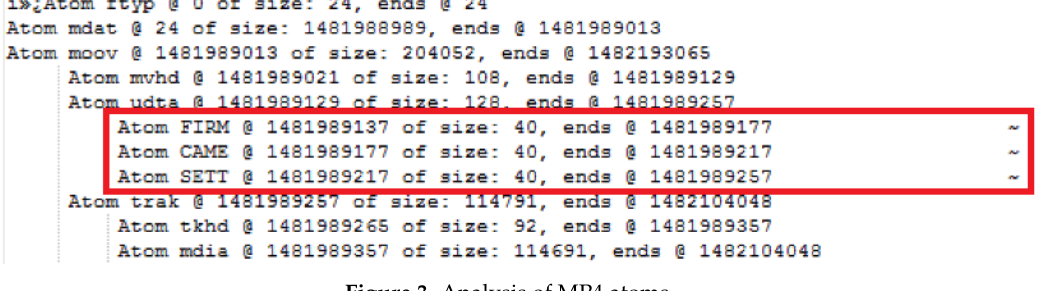
Figure 3. Analysis of MP4 atoms.